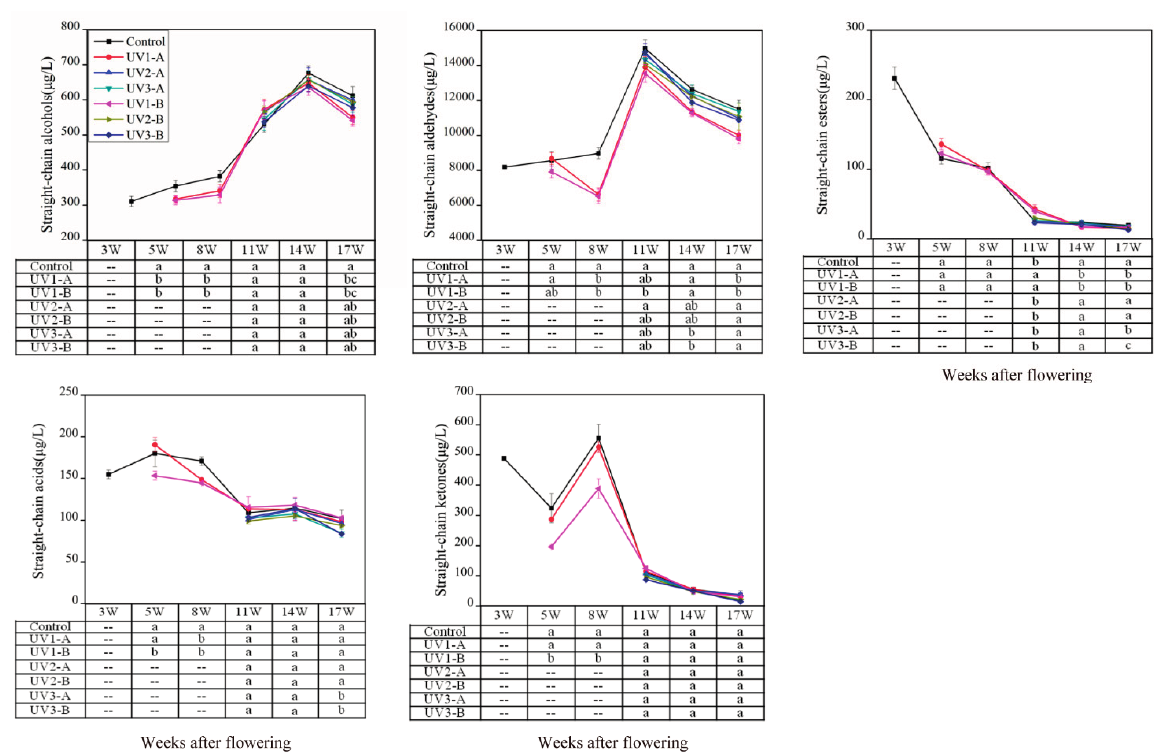
Figure 5. Effect of attenuated UV radiation on the concentration of fatty acid-derived volatiles in developing “Cabernet Sauvignon” grapes. For more information, please refer to the explanation in Figure